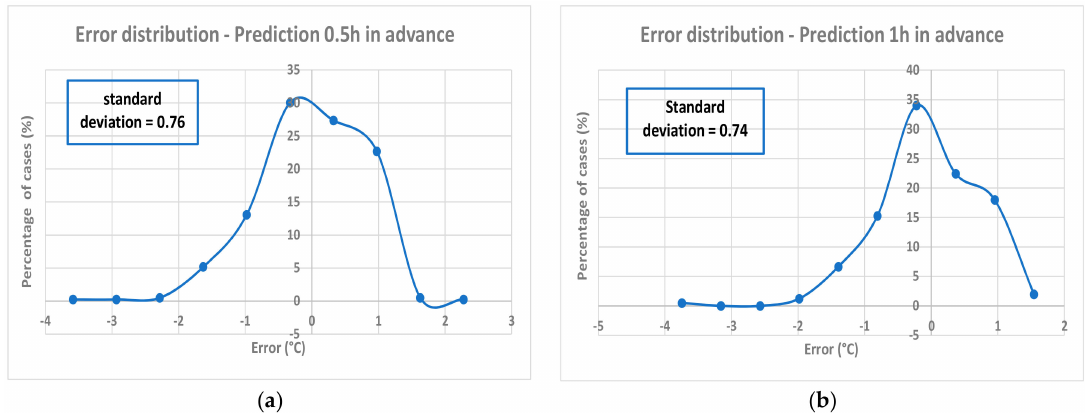
Figure 7. Distribution of the error forecasting (input parameter = outdoor temperature): ( a ) prediction for 0.5 h; and ( b ) prediction for 1